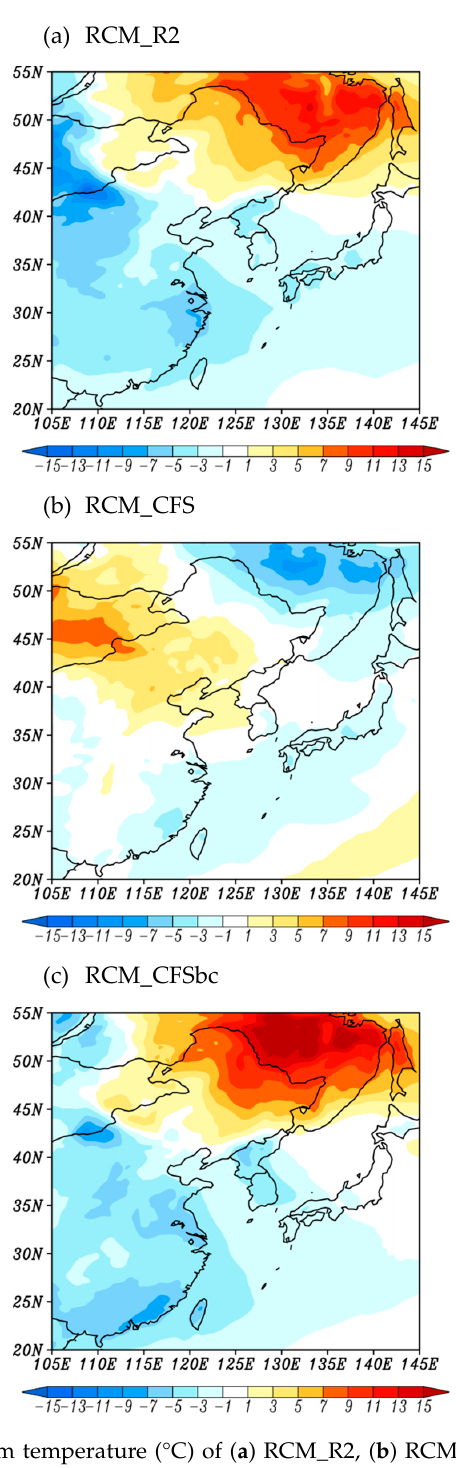
Figure 10. Anomaly of 2 m temperature (°C) of ( a ) RCM_R2, ( b ) RCM_CFS, and ( c ) RCM_CFSbc experiment during 2–5 December 2005.